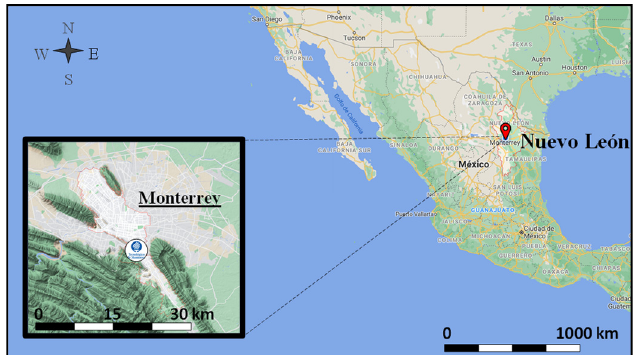
Figure 1. Region of study. Source: Google Maps.